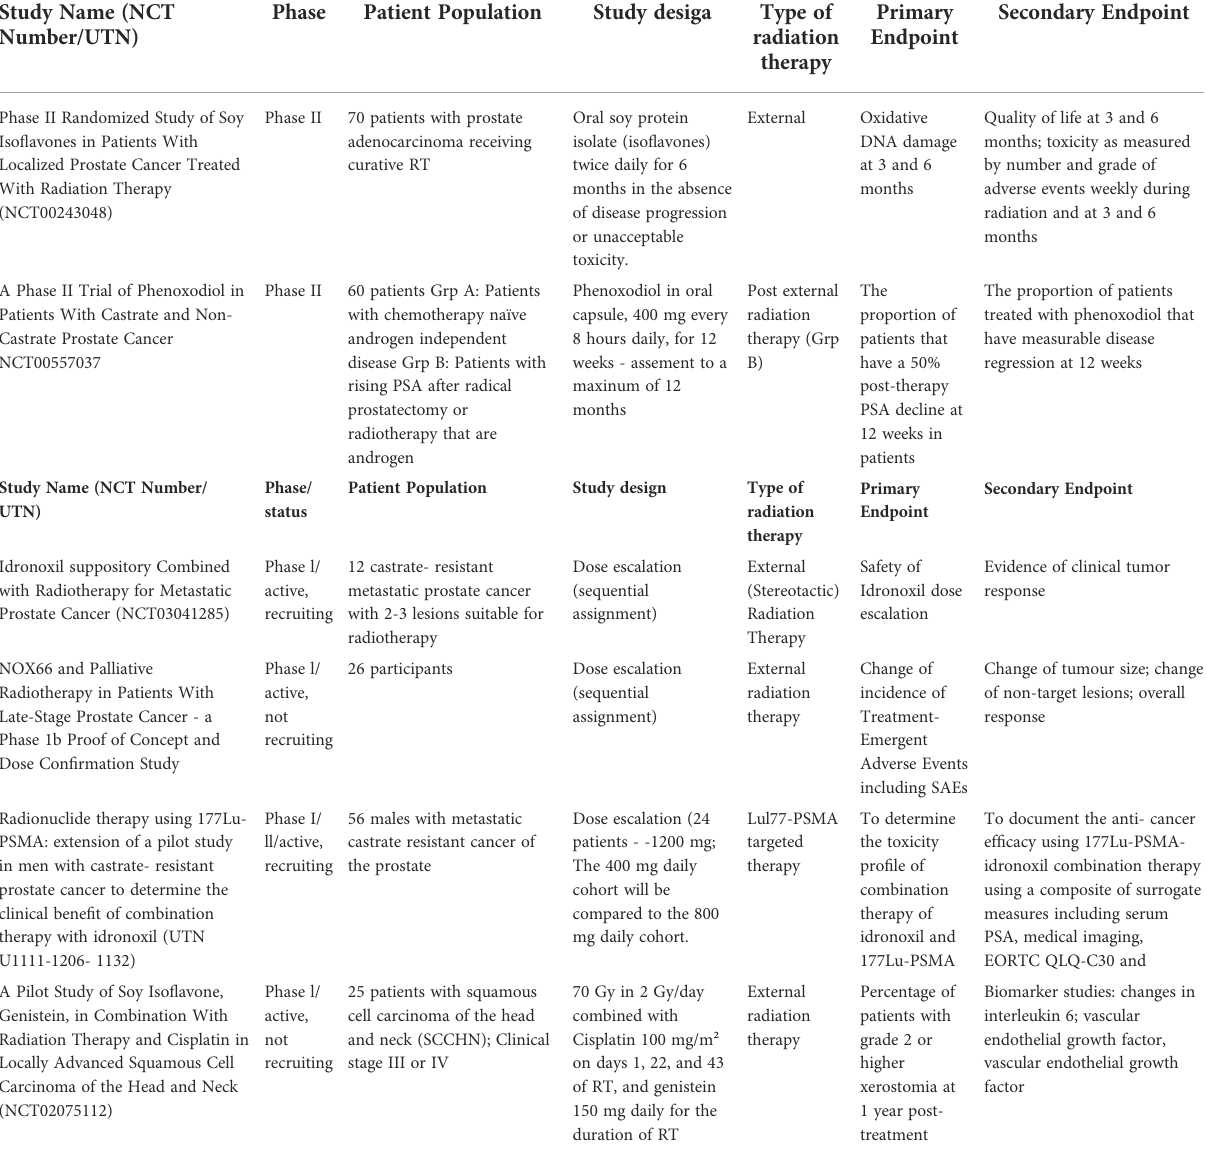
TABLE 1 Completed and ongoing clinical trials of iso fl avones in combination with radiation